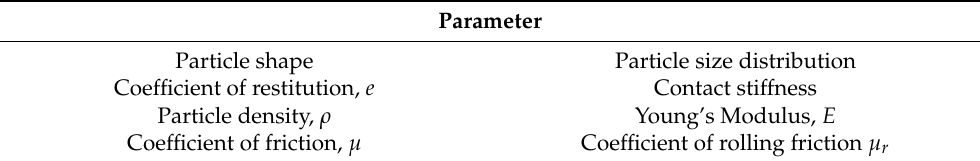
Table 1. List of parameters to be calibrated in a DEM simulation of non-cohesive